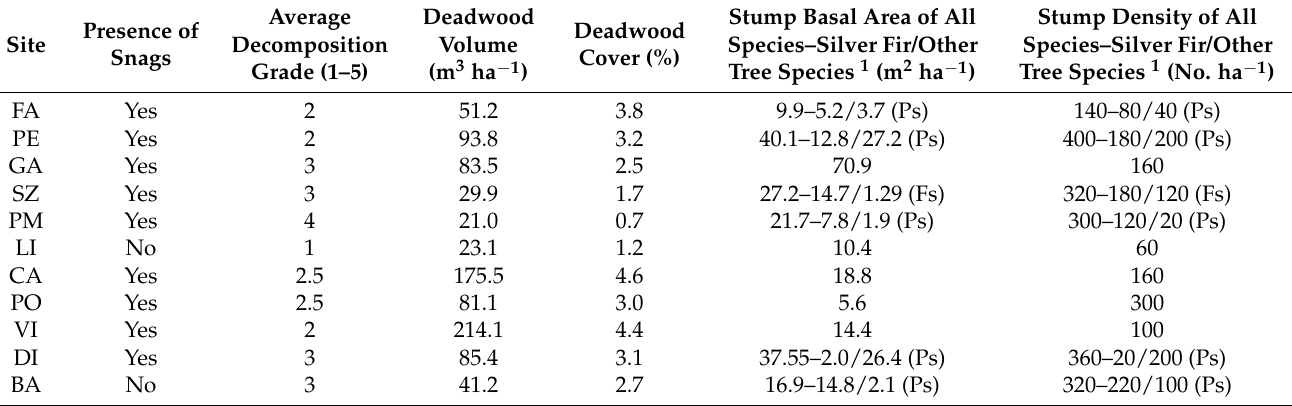
Table 3. Characteristics of deadwood according to the degree of decomposition and basal area, and density of stumps. The site codes are as in Table 1. The presence of snags was recorded in each site, and the lying deadwood was classified according to the degree of decomposition, into five categories (see Methods). In addition, the lying deadwood volume and cover were calculated using the line intercept method, and we also quantified the density and basal area of stumps, considering both silver fir as well as other species. The density and basal area and stumps were classified to the species level when possible due to the decomposition